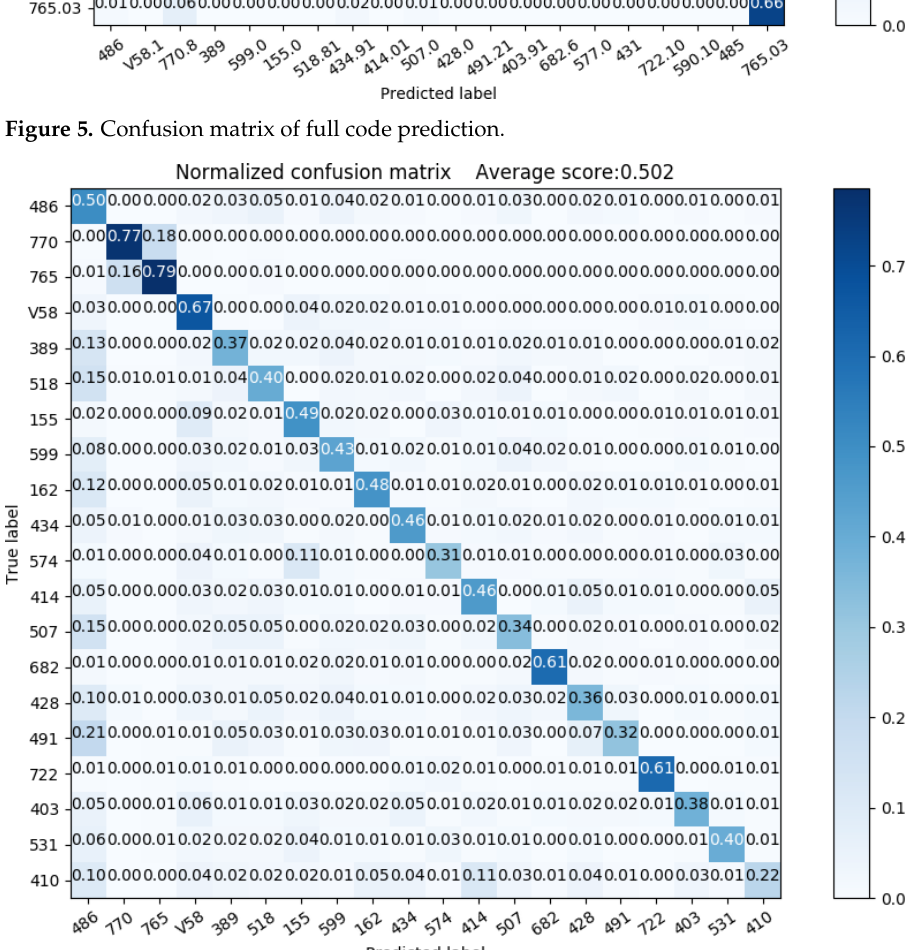
Figure 6. Confusion matrix of three-digit code